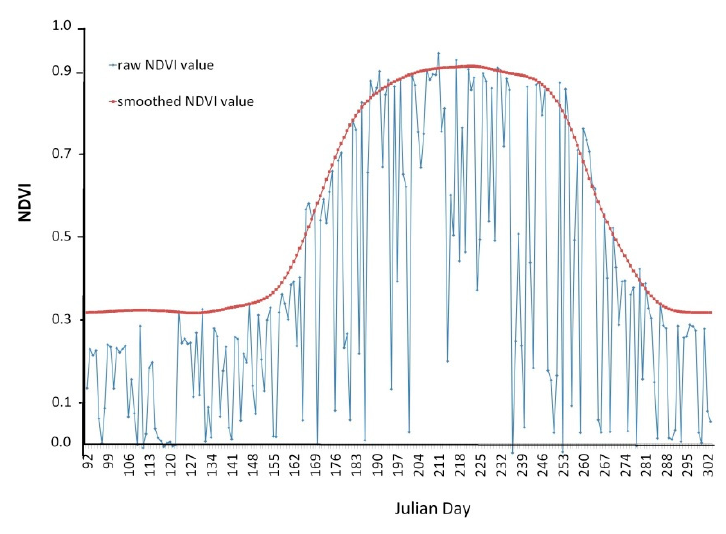
Figure 3. The original (in blue) and smoothed (in red) NDVI time series of a pure corn pixel. The extremely lower NDVI values (in blue) were removed and reconstructed by filtering and smoothing process.